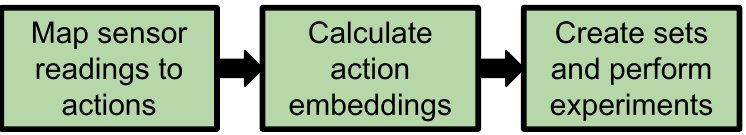
Figure 2. Evaluation steps.